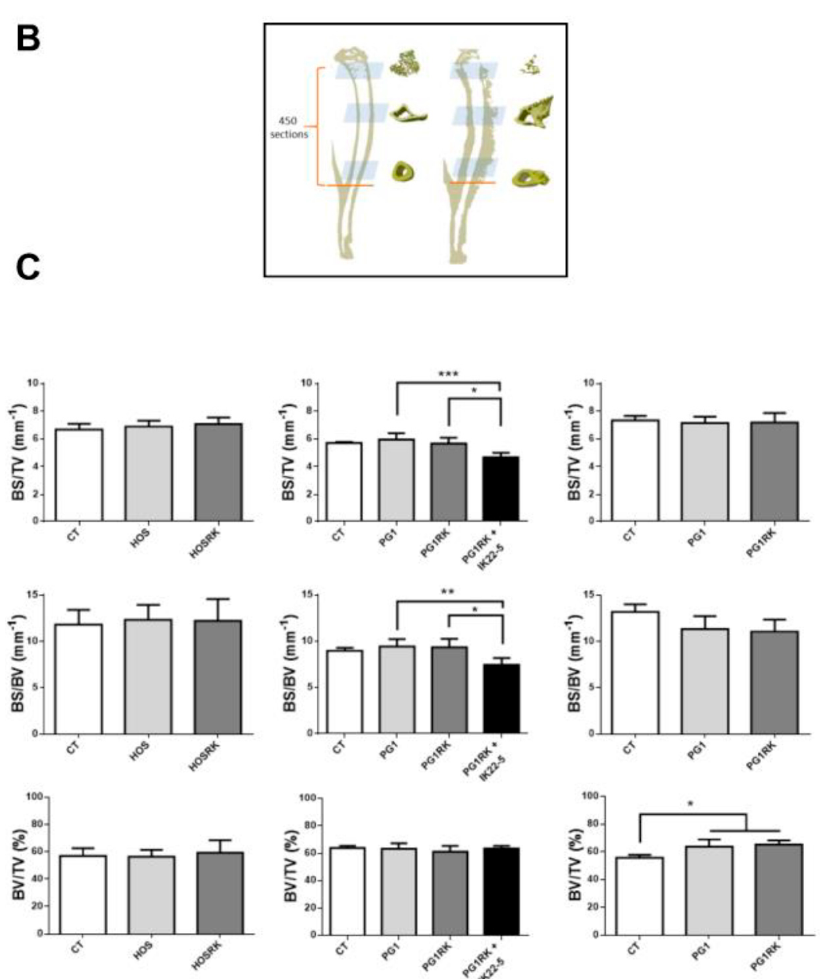
Figure 4. Consequences of T-cell specific invalidation of Rankl in recipient mice on RANK over-expressing PG1 tumor growth, number of metastases and bone parameters. Rankl depletion in mouse T-cells (LCK-CRE) was validated by PCR on gDNA extracted from tails and T cells ( A ). PCR data confirmed the effective recombination, specifically in T-cells. After injection of one million PG1 cells over-expressing RANK, tumor growth ( B ) and the number of lung metastases formed ( C ) were compared between mice invalidated for Rank in T-cells ( n = 4) and control mice ( n = 5) showing no difference. Representative three-dimensional images of tibias with tumors (and their controls, C ) did not make it possible to observe any differences regarding bone resorption or tumor osteoid tissue formation ( D ). Micro-CT analysis of the BS/TV (mm-1), BS/BV (mm-1) and BV/TV (%) parameters of the tibias revealed no differences. However, an increase in BV/TV was observed comparatively to contralateral safe tibias, independently of the mouse genotype ( E ). The data in ( E ) are shown as the mean ± SD. Data analyses were performed using the Kruskal Wallis test. ns: no significant. *: p < 0.05.